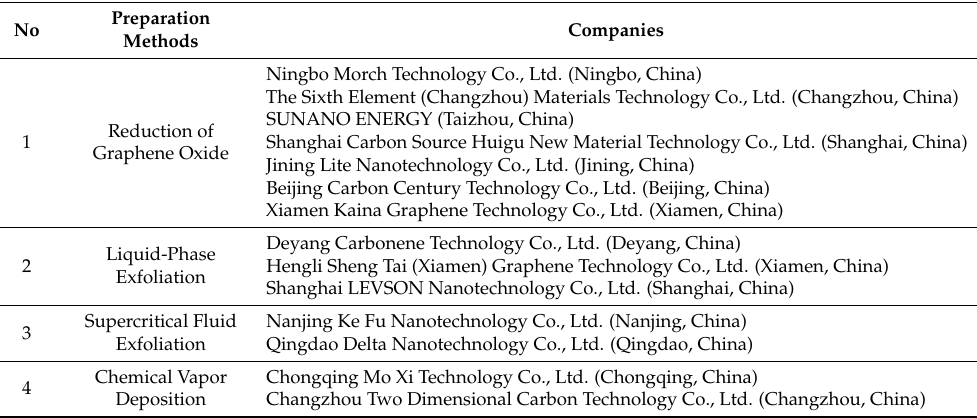
Figure 4. There are several methods of mass-production of graphene, which allow a wide choice in terms of size, quality and price for any particular application. Reproduced from [9]. Copyright Nature Publishing Group, 2012. Table 1. Graphene preparation process of some Chinese companies